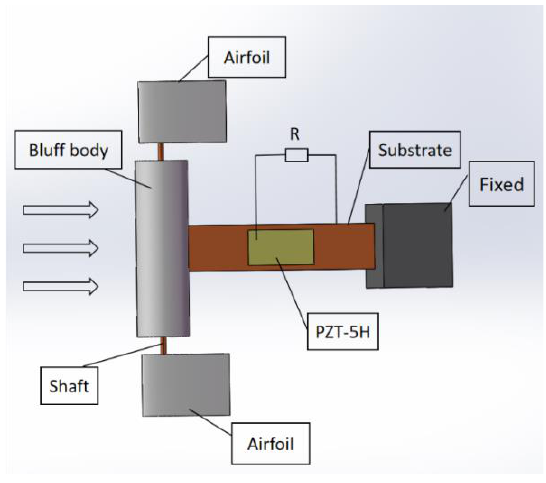
Figure 1. Schematic diagram of the